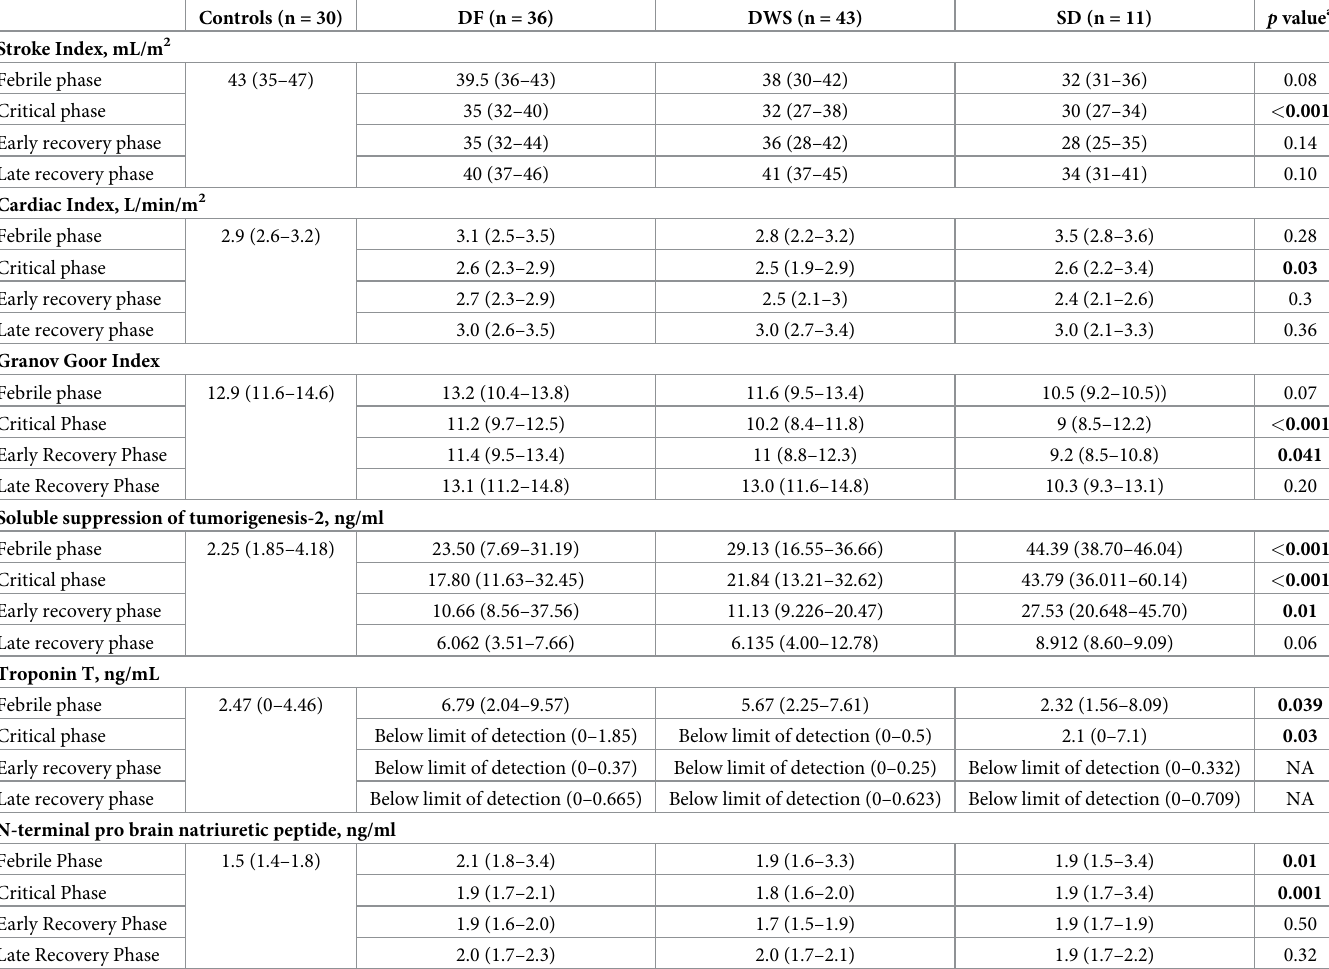
Table 2. Longitudinal comparison of cardiac parameters and plasma cardiac biomarkers in dengue fever, dengue with warning signs, severe dengue patients and